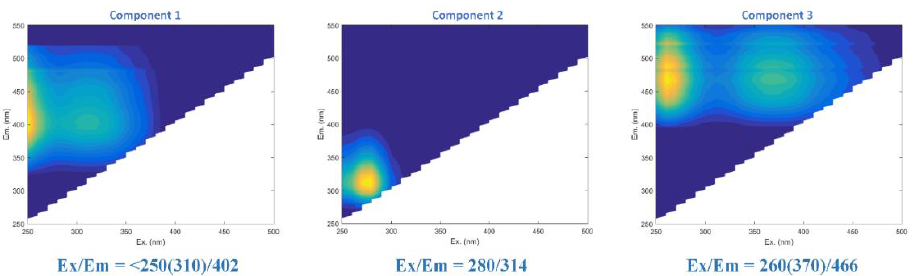
Figure 3. Components (i.e., C1, C2, and C3) identified using the EEM-PAPARAFAC method for the 2nd evaluation.